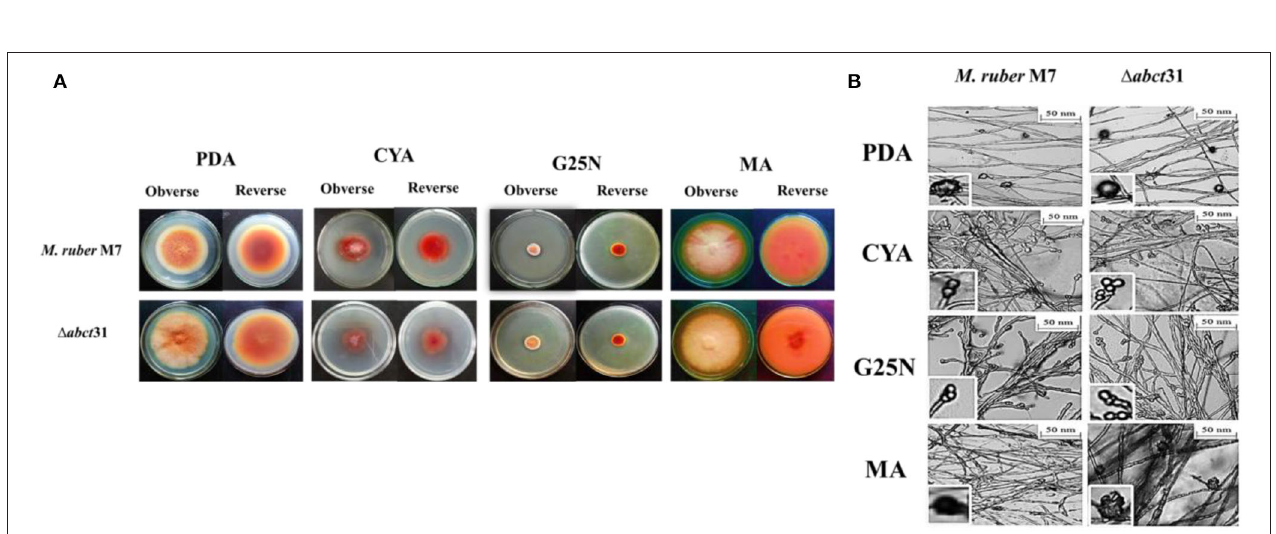
FIGURE 7 | Morphological comparison of M. ruber M7and 1 abct 31. (A) Colony morphology of M. ruber M7 and 1 abct 31 on PDA, CYA, G25N, MA plates, and cultured at 28 ◦ C for 15 days; (B) Cleistothecia and conidia development in M. ruber M7and 1 abct 31 inoculated on PDA, CYA, G25N, MA plates, and cultured at 28 ◦ C for 8